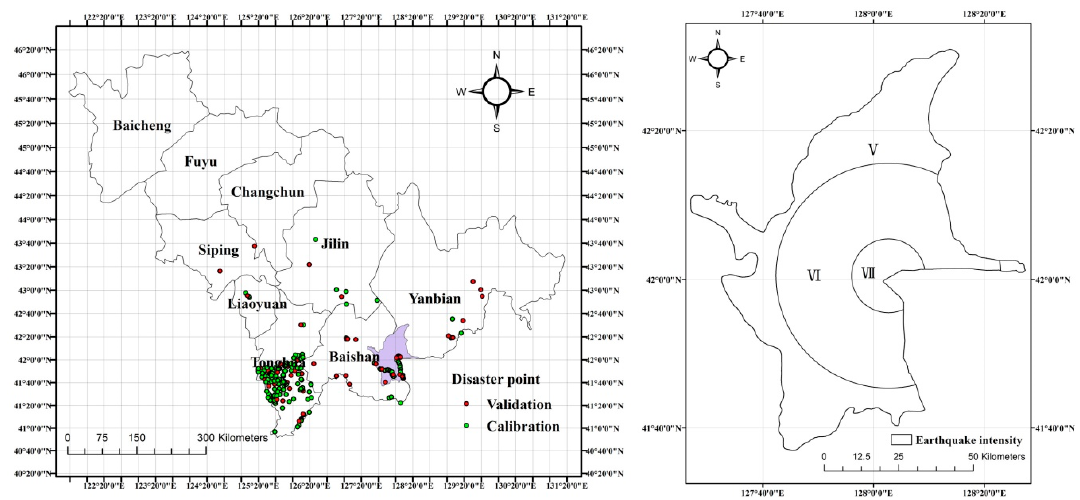
Figure 2. The map of disaster points’ location, and earthquake intensity zones of the study area.